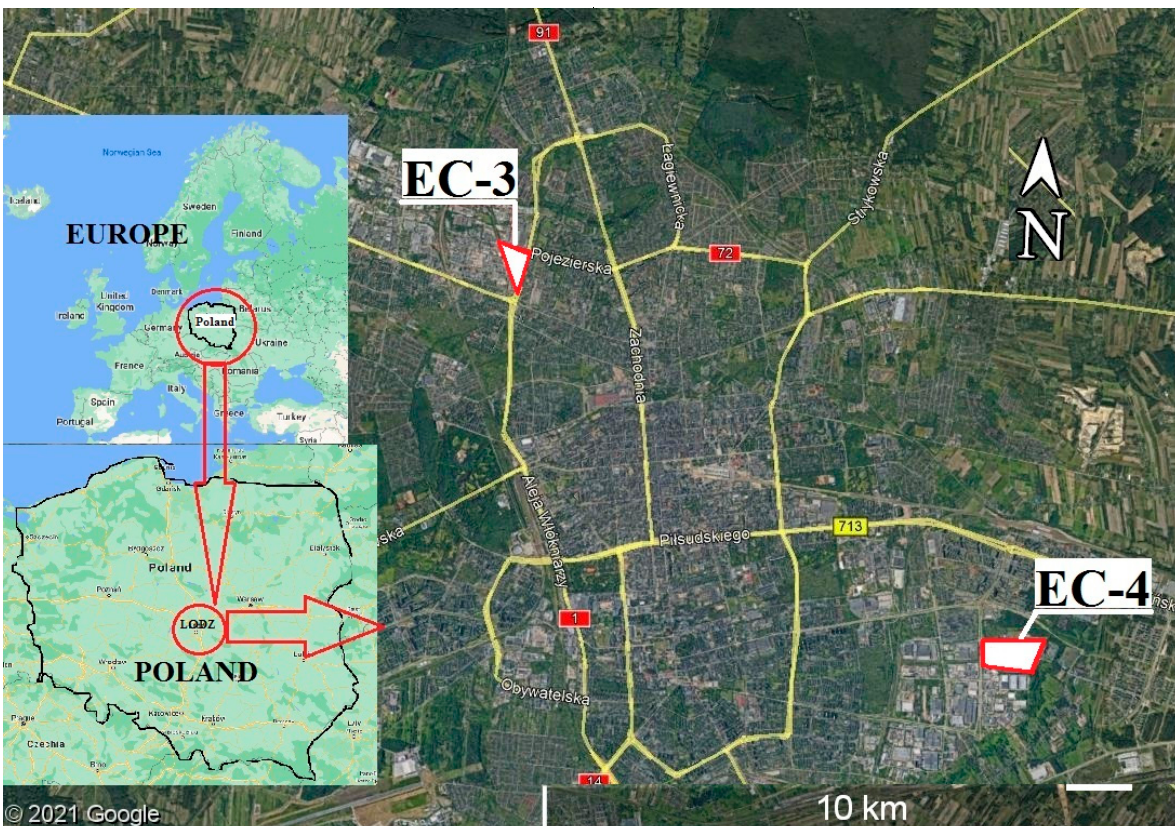
Figure 1. Location of the EC-3 and EC-4 CHP plants in the city of Lodz in Poland, Europe (photo background source: Google Earth Pro).